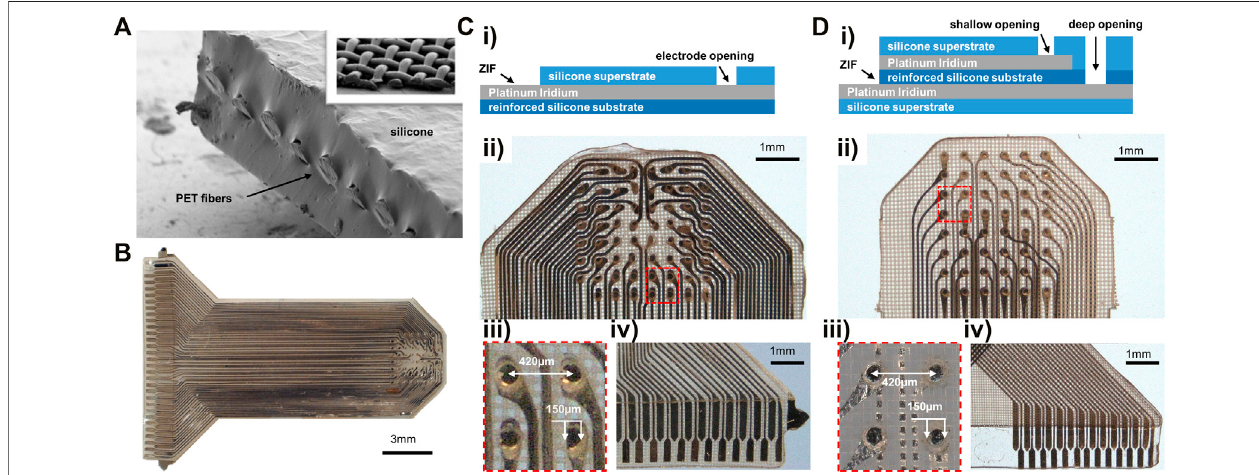
FIGURE1| Materialsandpassiveelectrodearrayfabrication. (A) SEMofreinforced siliconesubstratecrosssection, withinsetshowingtheinterwoven PETmicro- threads in top right. (B) 61-channel monolayer reinforced silicone electrode array. (Ci) Stackup for monolayer electrode array fabrication. (Cii) Monolayer reinforced silicone uECoG array contacts. (Ciii) Close-up of four electrode sites in Cii. (Civ) Exposed pads for ZIF connector attachment. The horizontal line shows where the superstrate ends to keep the ZIF pads exposed for contact. (Di) Stackup for two-metal layer electrode array fabrication. (Dii) Two-layer reinforced silicone electrode array with electrodes sitting at two depths within substrate. (Diii) Close-up of four electrodes from Dii at two depths: darker metal on the left in layer 1, fainter electrodes on right in layer two behind a layer of meshed silicone. (Div) ZIF connector portion of two-layer electrode with overlapping traces in top corner patterned on separate layers.